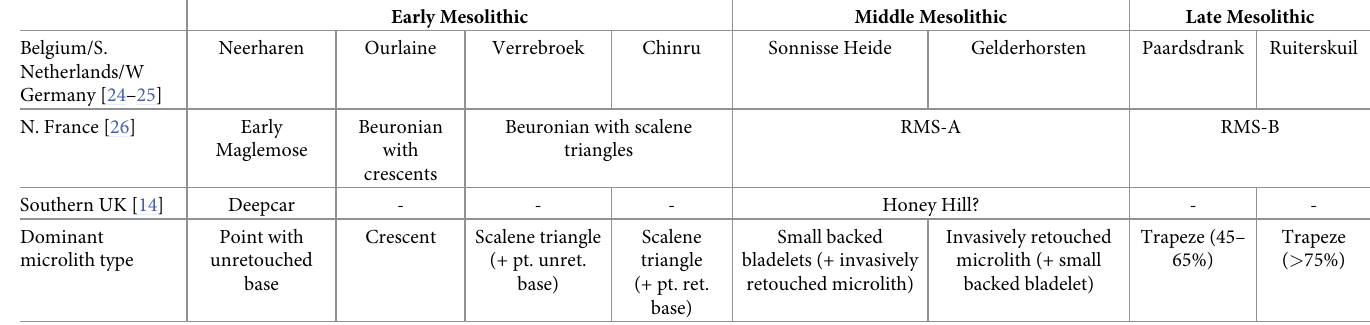
Table 1. Overview and correspondence of the main ATs identified within the different research areas of the Rhine-Meuse-Scheldt region.